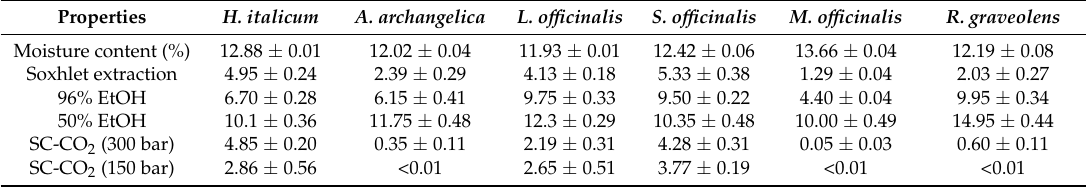
Table 1. The percentages of extraction yields and moisture content of the plant materials.